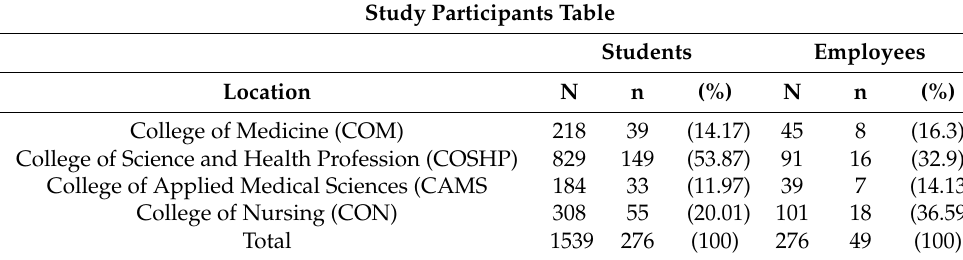
Table 1. Sampling study